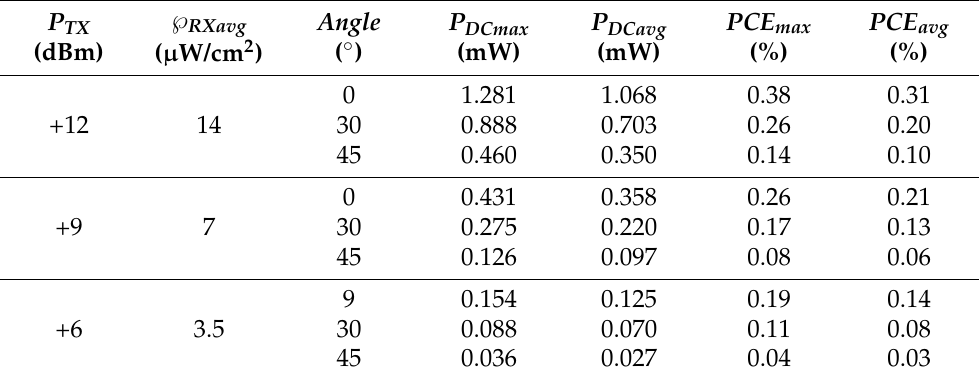
Table 7. 2 × 2 Rectenna Array Measurements (2.40–2.48 GHz